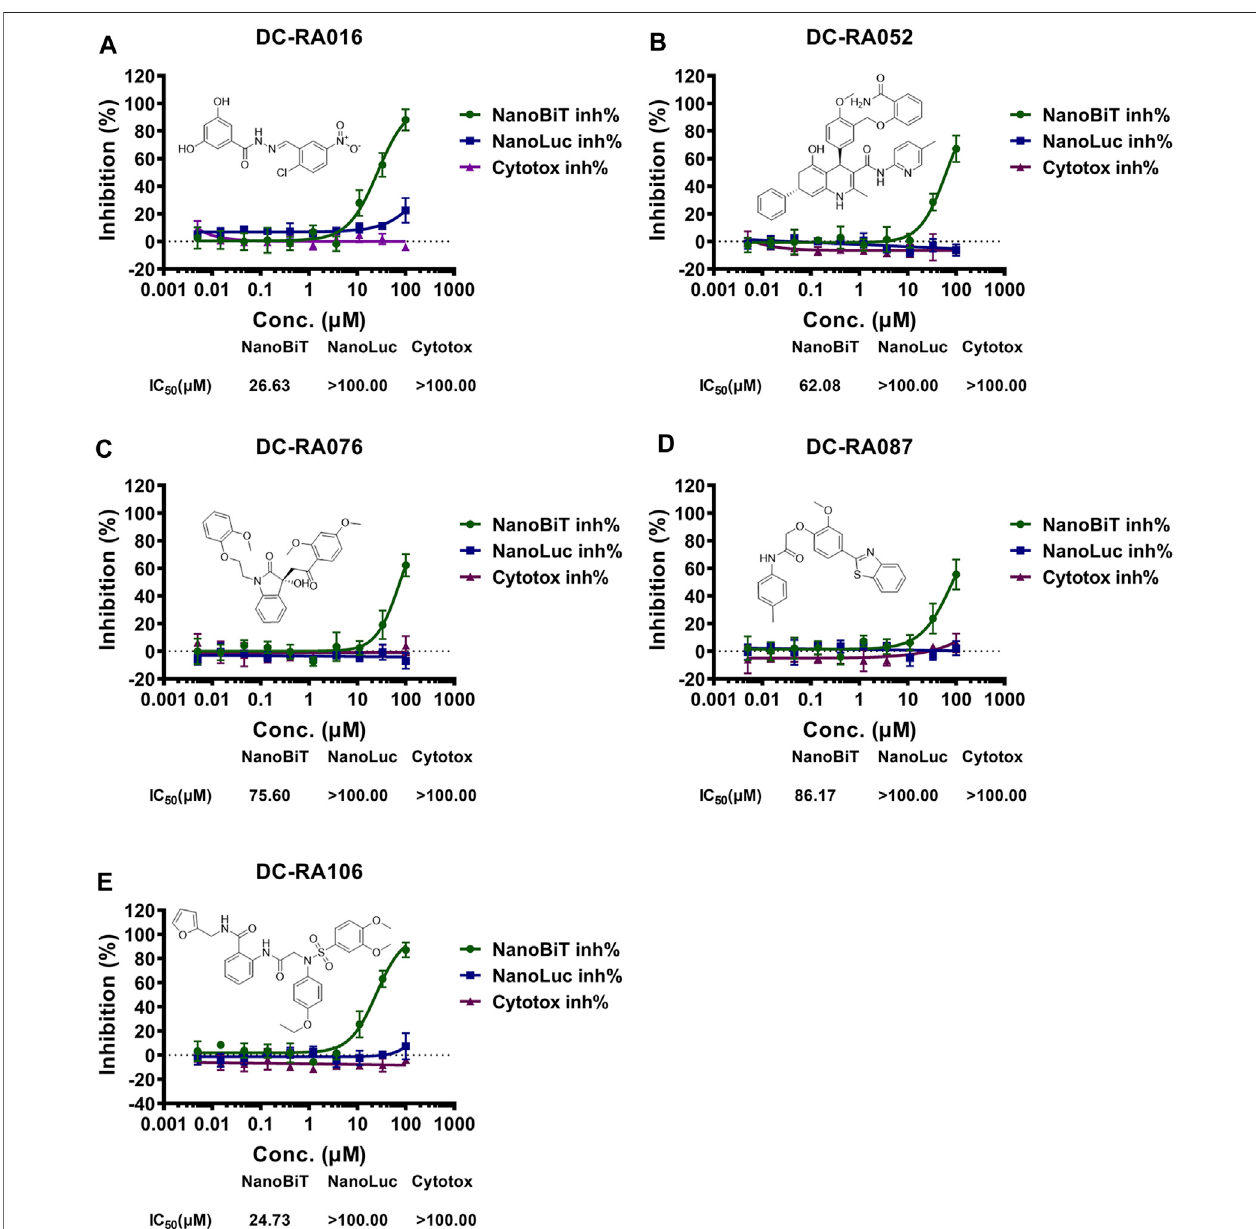
FIGURE 3 | NanoBiT-based SARS-CoV-2 S-RBD/ACE2 interaction assays for fi ve compounds: (A) DC-RA016; (B) DC-RA052; (C) DC-RA076; (D) DC-RA087; (E) DC-RA106. NanoBiT inh%: the inhibition rates against SARS-CoV-2 S-RBD/ACE2 interaction; NanoLuc inh%: the inhibition rates against NanoLuc luciferase; Cytotox inh%: the inhibition rates against the transfected HEK293 cell proliferation. n (cid:2) 3.